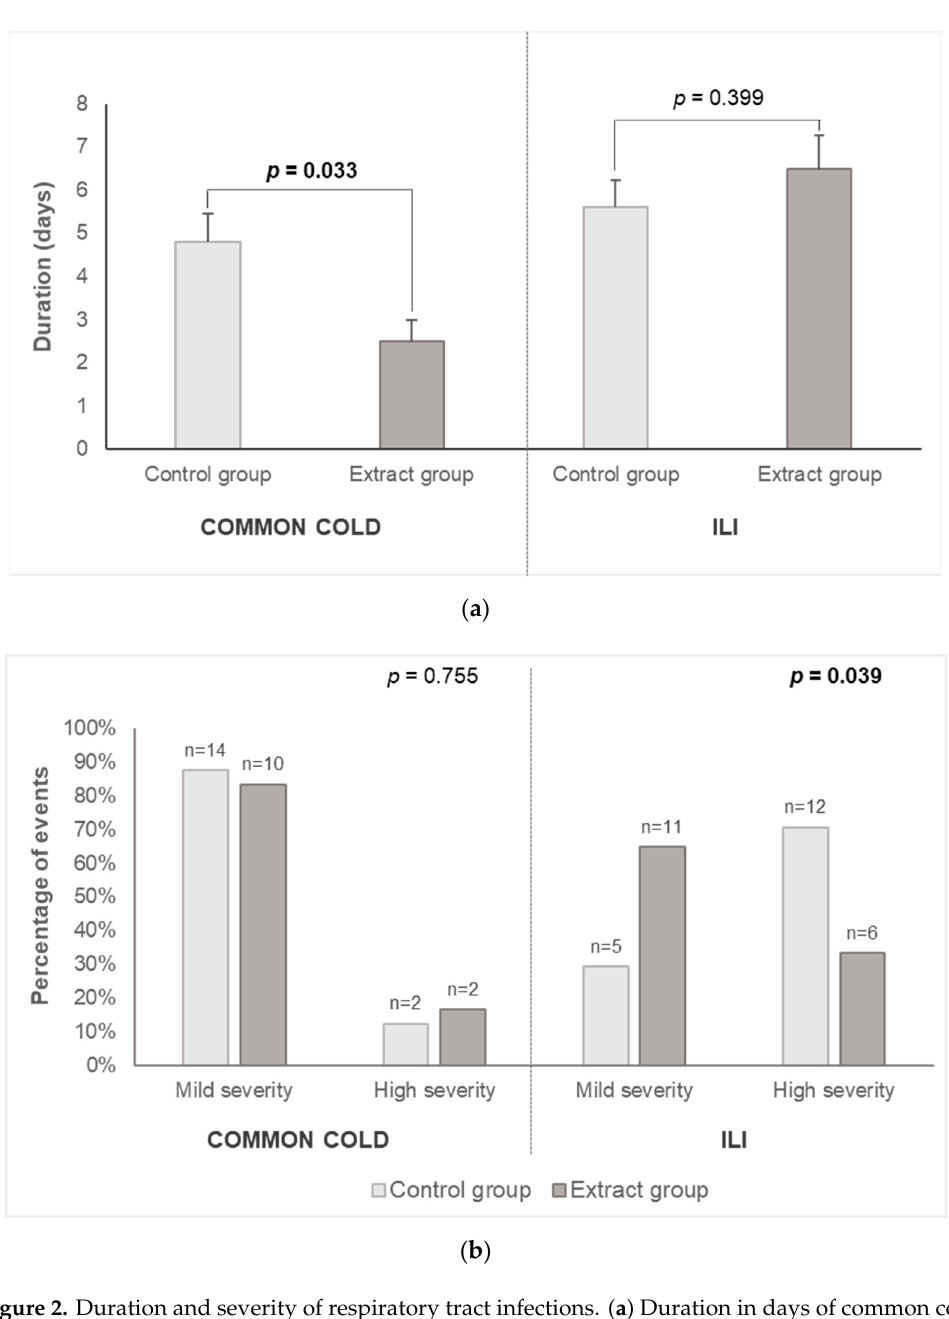
Figure 2. Duration and severity of respiratory tract infections. ( a ) Duration in days of common cold and influenza-like illness (ILI) events according to intervention groups. Values are represented as mean ± standard error of mean (SEM) (light grey bars for control group and dark grey bars for extract group). p -value indicates differences between groups for the duration of common cold or ILI events (univariate model adjusted by sex, age and smoking habits). ( b ) Percentage of events (common cold or ILI) that course with mild or high severity according to intervention groups (light grey bars for control group and dark grey bars for extract group). The number above each bar indicates the number of events in that group. p -value indicates differences in severity of common cold or ILI events between groups (chi-square test). Statistically significant values ( p < 0.05) are given in bold.